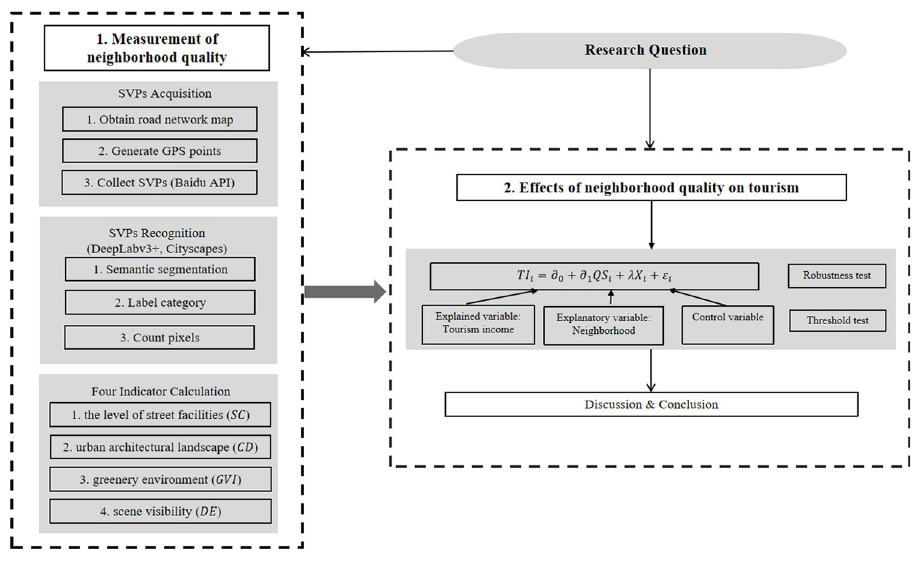
Fig 1. The methodological flow chart of this